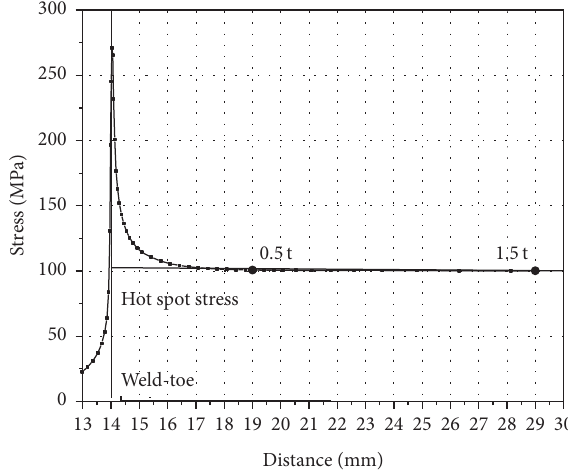
Figure 20: Longitudinal stress